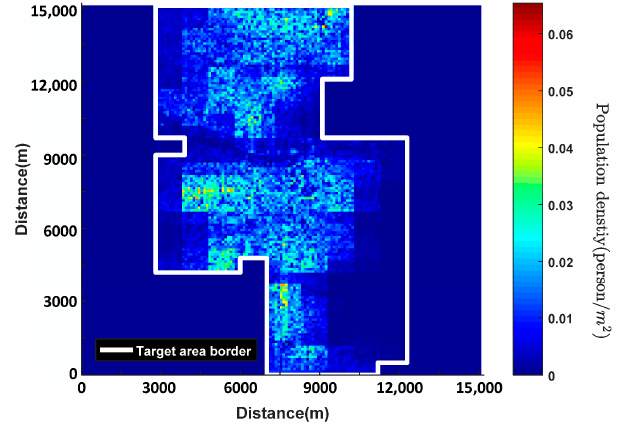
Other areas are invalid without data collection.